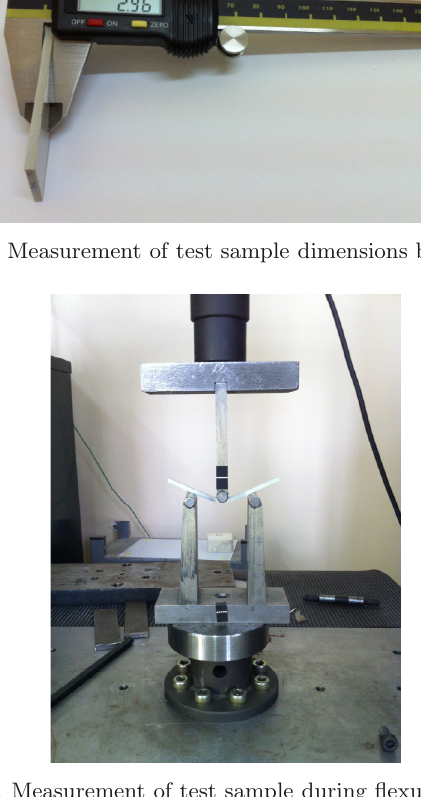
Fig. 3. Measurement of test sample during flexure testing.